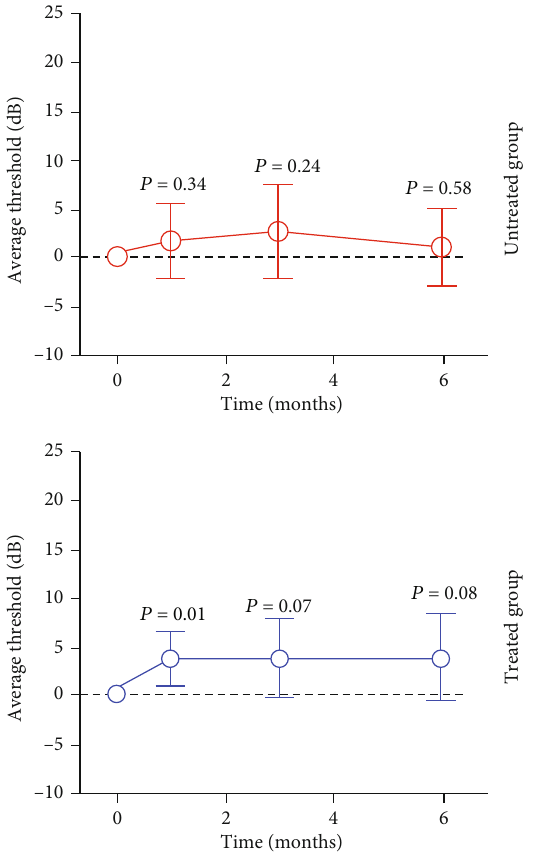
Figure 3: Graphical representation of the evolution of the mean sensitivity threshold in microperimetry in relation to the follow-up time in months and the di ff erent levels of signi fi cance ( P ) of the treated and untreated